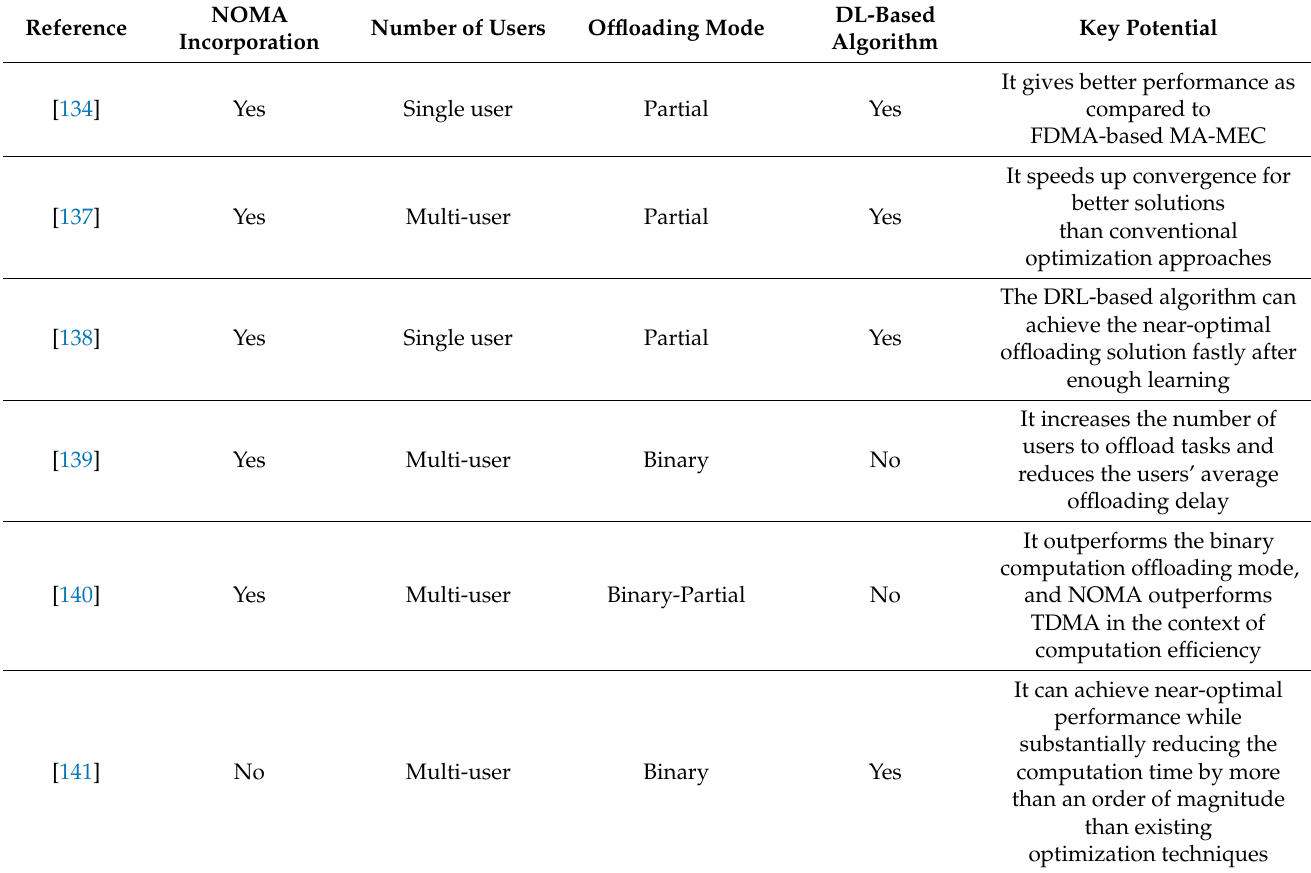
Table 4. Summary of studies on MEC scenario